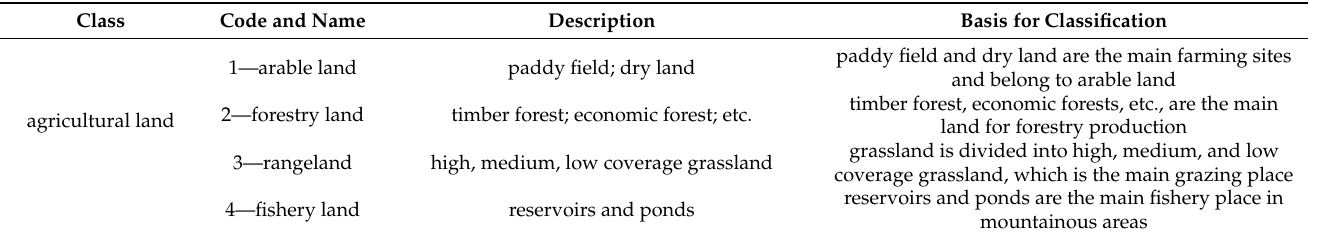
Table 1. Agricultural land classification